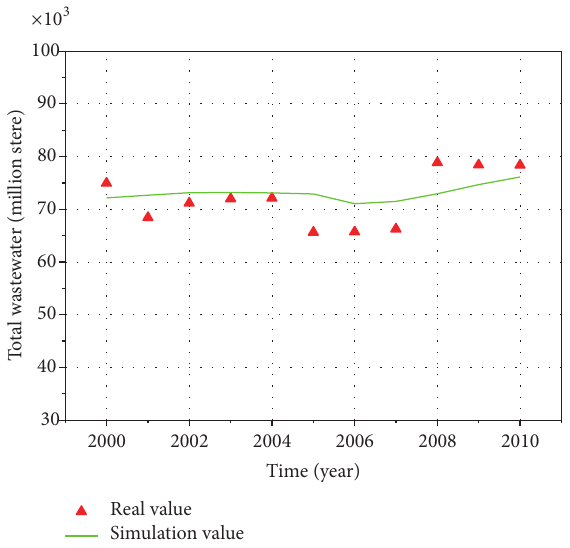
Figure 3: The comparison of the real value and the simulation